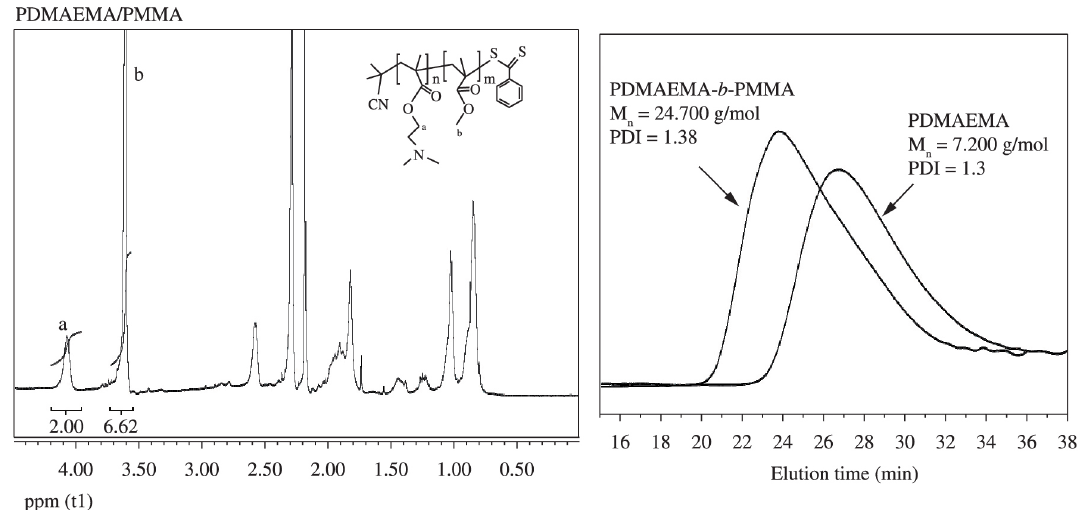
Figure 1. 1 H NMR spectrum of the PDMAEMA- b -PMMA (left) and SEC traces of PDMAEMA (MCTA) and PDMAEMA- b -PMMA diblock copolymer